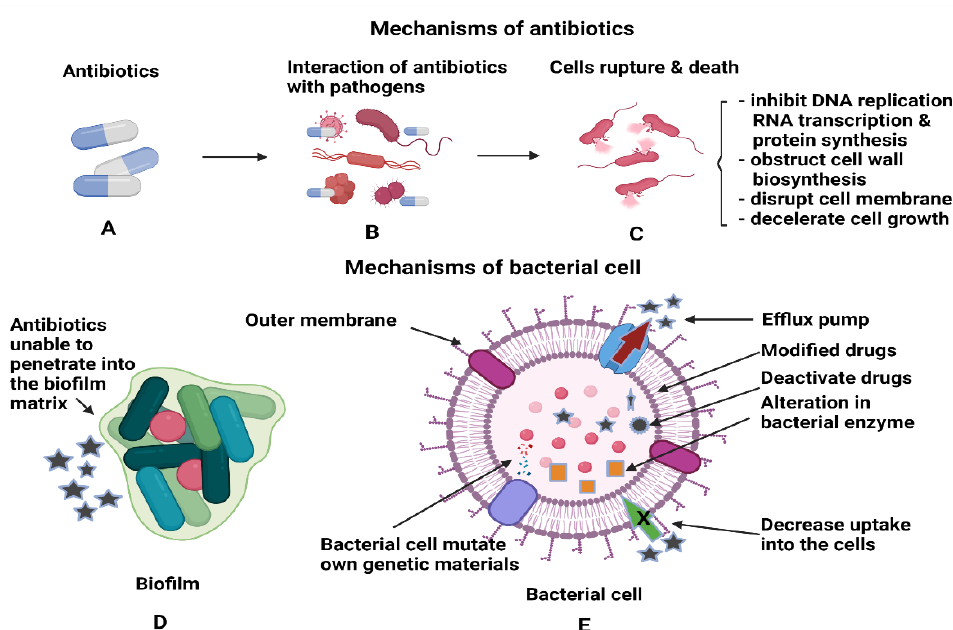
Figure 3. Illustrations of ( A , B ) the interactions of antibiotics with the pathogens and ( C ) antibiotics’ activities after penetration into each bacterial cell to kill the cells. ( D ) Antibiotics inefficiency n killing the bacterial cells, as the cells are protected within the biofilm and ( E ) the mechanisms utilised by bacterial cells to render the antibiotics’ functions.